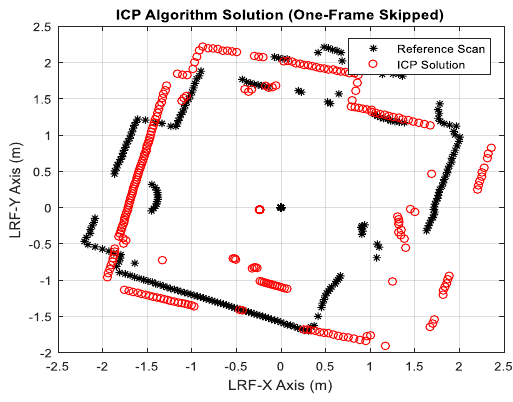
Figure 8. ICP algorithm performance when the step size is one frame skipping (second experiment, one frame skipped).